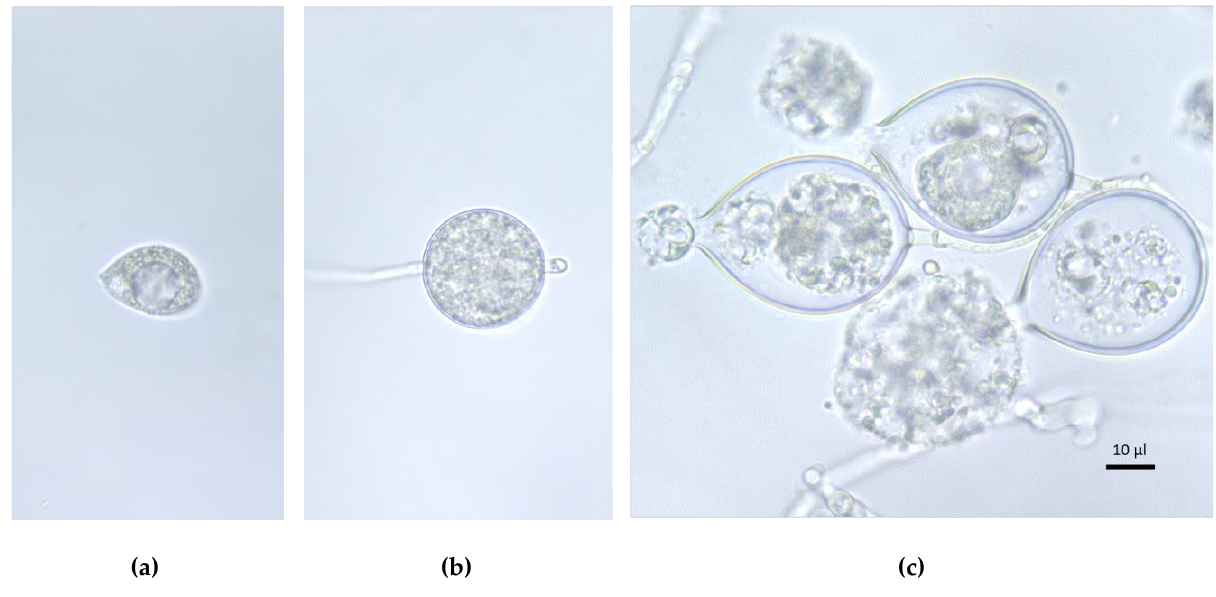
Figure 1. Morphological features of zoospores and sporangia, and sporulation pattern of P. cactorum isolate PhF66– on clarified VA. ( a ) A zoospore observed after stimulated zoospore release; ( b ) direct proliferation of PhF66– sporangium, and ( c ) release of cytoplasm from the sporangia. Scale bar = 10 µm. Differences in sporangia production and morphological characteristics were observed between isolates PhF66 and PhF66–. PhF66 produced significantly less ( p < 0.01)